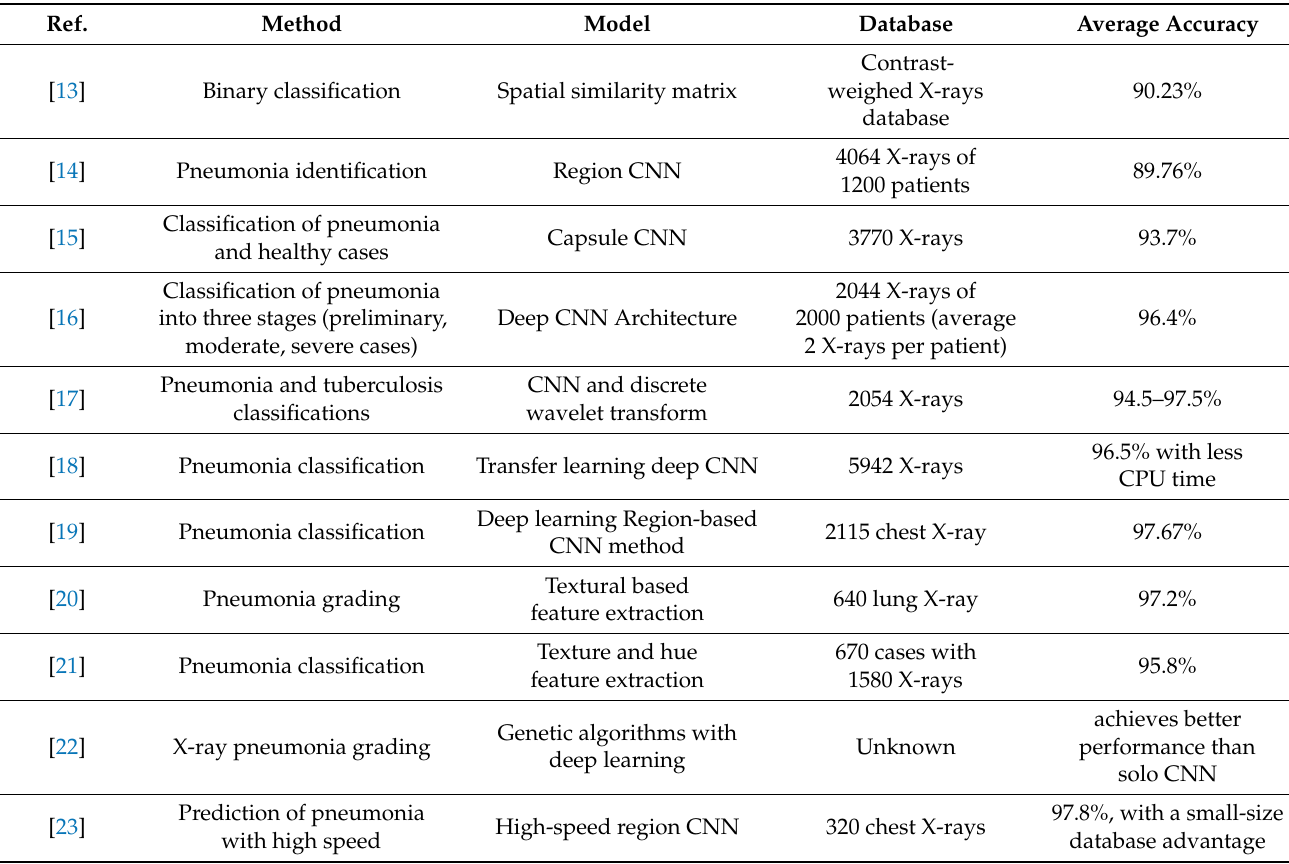
Table 1. Recent research in pneumonia prediction deep learning models. Ref.